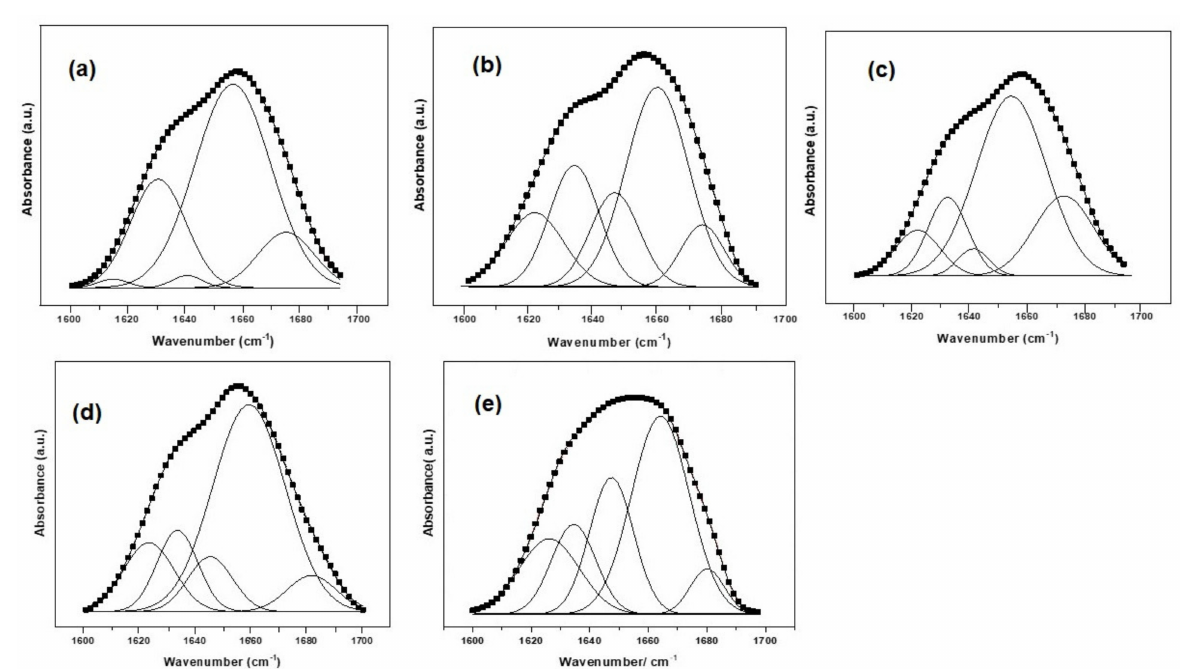
Figure 5. Computational fitting of the amide I FTIR spectroscopy absorption band after different treatments: ( a ) natural membrane (AMN), ( b ) 1 h exposure to UV (AUV), ( c ) gentamicin treatment (40 mg/mL) with 1 h exposure to UV (AGUV),